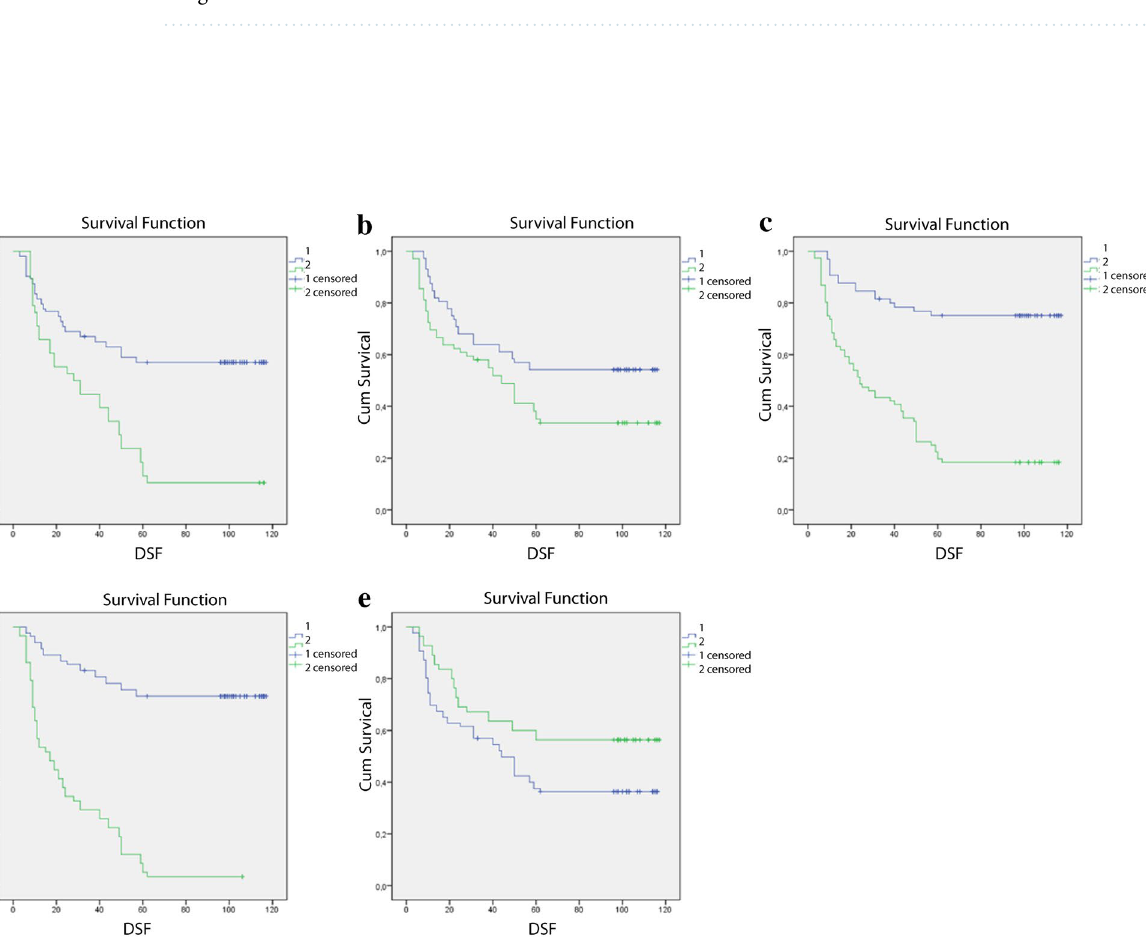
Table 4. Results of the Log rank test for the disease-free interval (DFS) according to the examined indicators. *Log rank test.